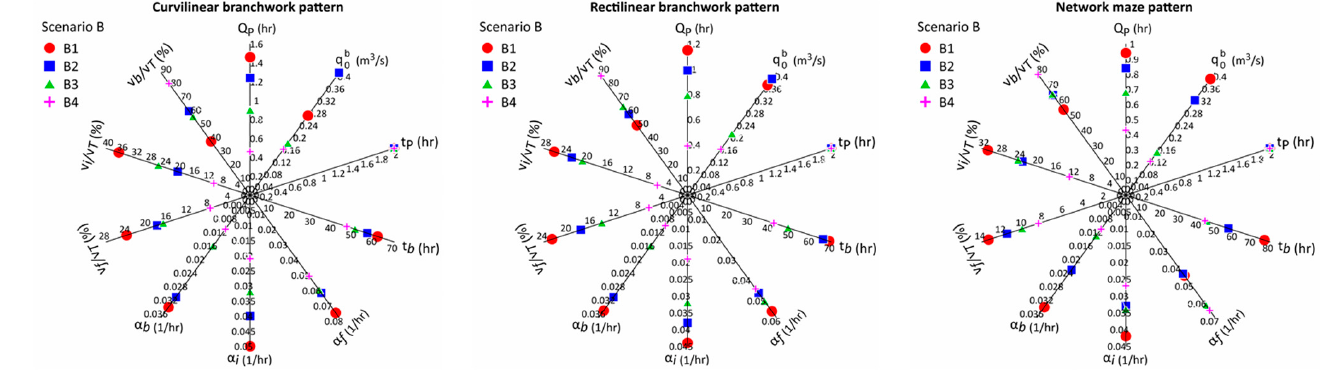
Figure 15. Comparison of different spring hydrograph characteristics in scenario B.